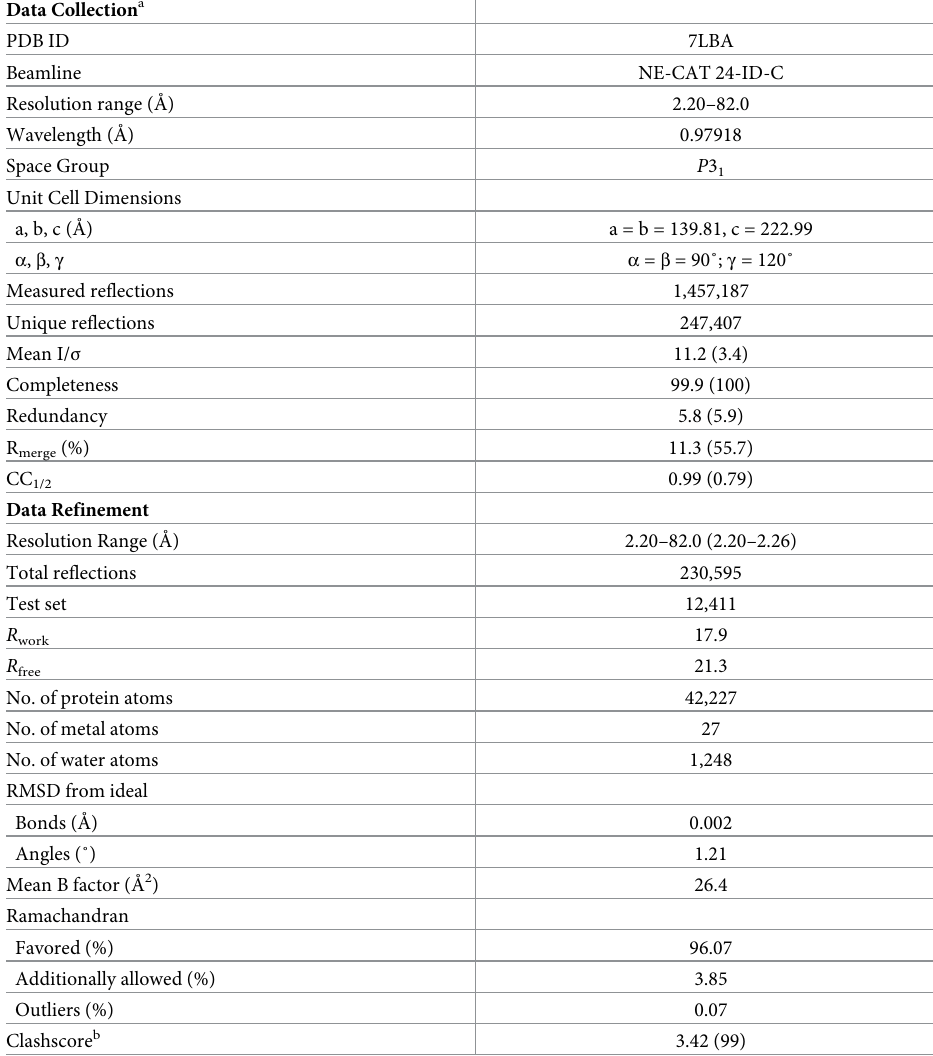
Table 1. Data collection and refinement